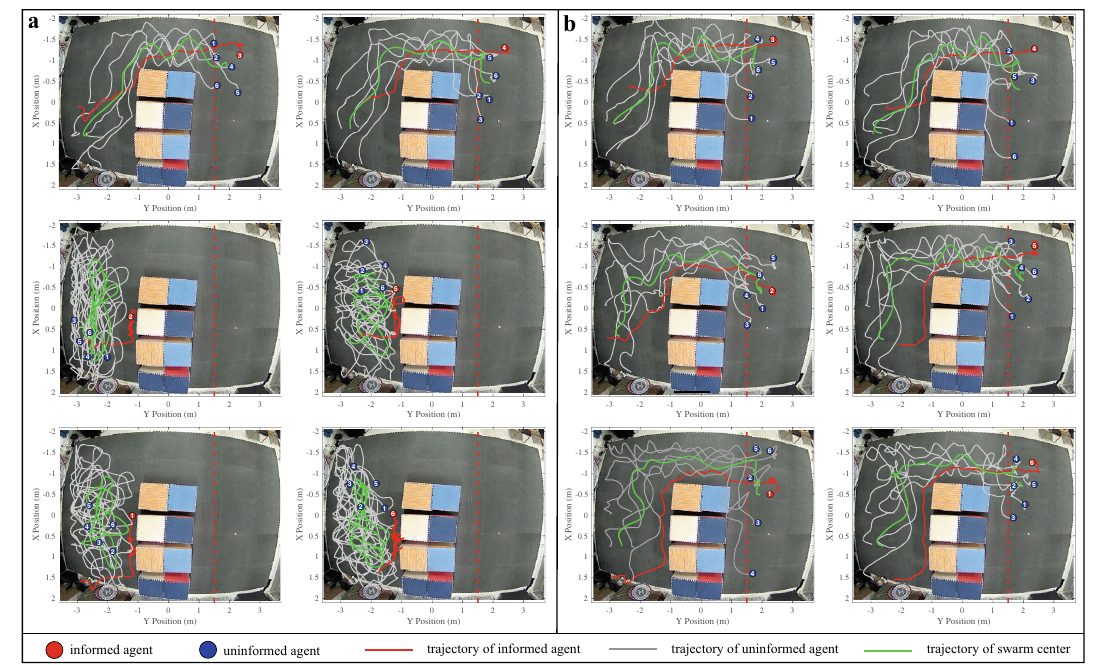
Fig. 10 Experimental diagram of the flight trajectory of the drone swarm when the informed agent is in different initialpositions. a Exper- imental results of the proposed flocking algorithm with non-AGDS.